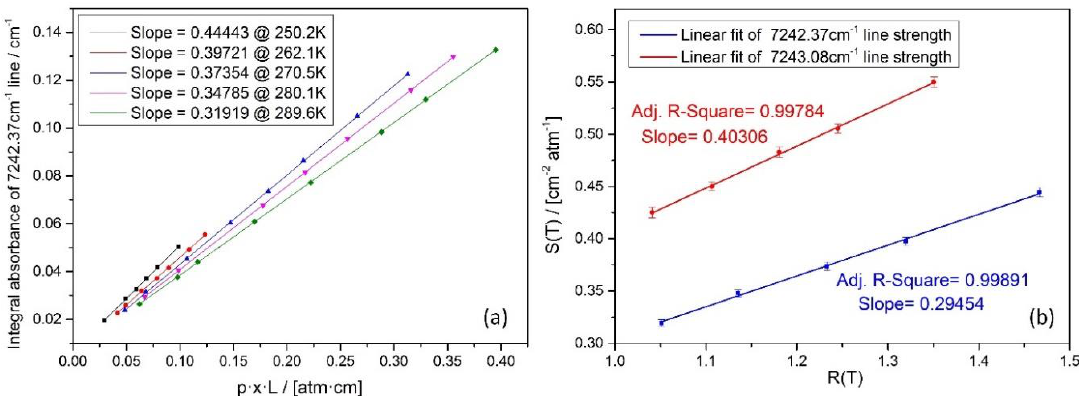
Figure 1. ( a ) Measured integral absorbance of the 7242.37 cm − 1 line at different pressure and the results of straight line fitting. The linear slope value is the absorption line strength at the corresponding gas temperature. ( b ) straight line fit of the line strength as a function of R(T) at different gas temperatures. The linear slope value is the line strength at the reference temperature 296 K.